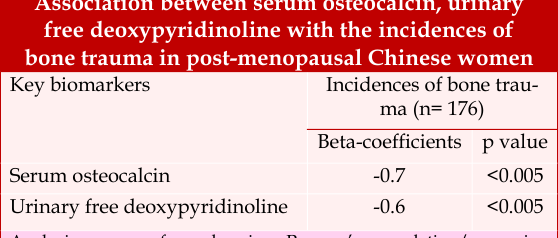
Association between serum osteocalcin, urinary free deoxypyridinoline with the incidences